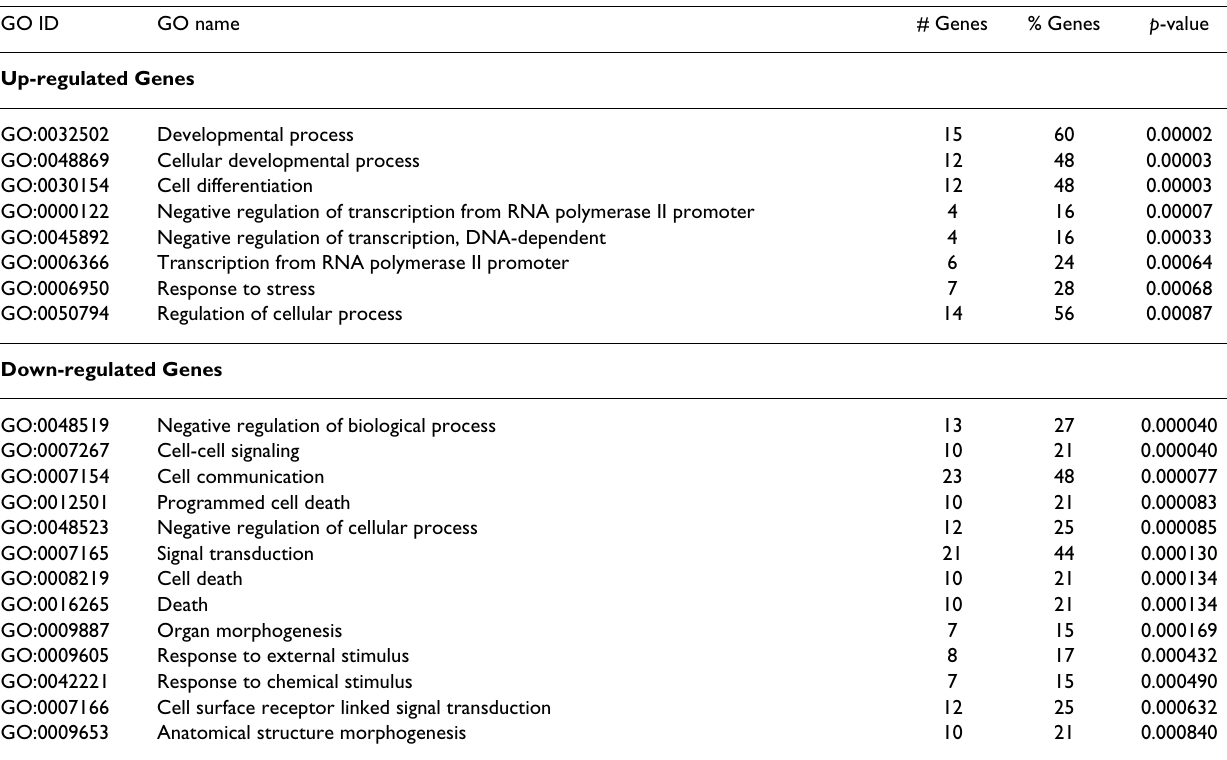
Table 3: Summary of Gene Ontology (GO) term